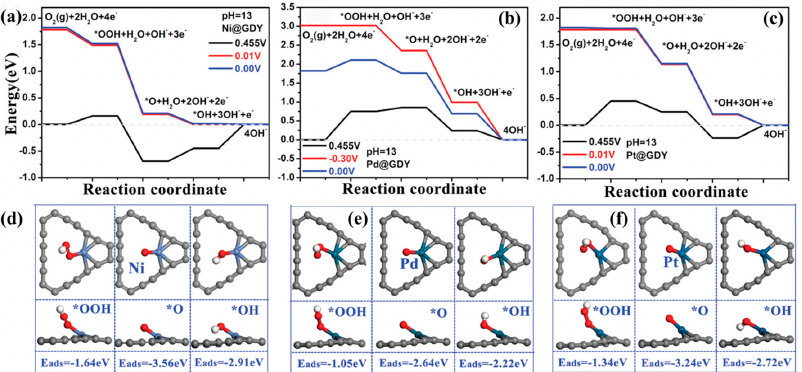
Figure 7. ORR free energy and intermediate adsorption diagrams of metal-atom-anchored GDY. The ORR free energy diagrams of ( a ) Ni@GDY, ( b ) Pd@GDY and ( c ) Pt@GDY. Optimized adsorption structures for *OOH, *O and *OH on ( d ) Ni@GDY, ( e ) Pd@GDY and ( f ) Pt@GDY monolayers. The gray, red and white balls represent C, O and H atoms, respectively (reproduced with permission from [95] . Copyright The Royal Society of Chemistry, 2019).